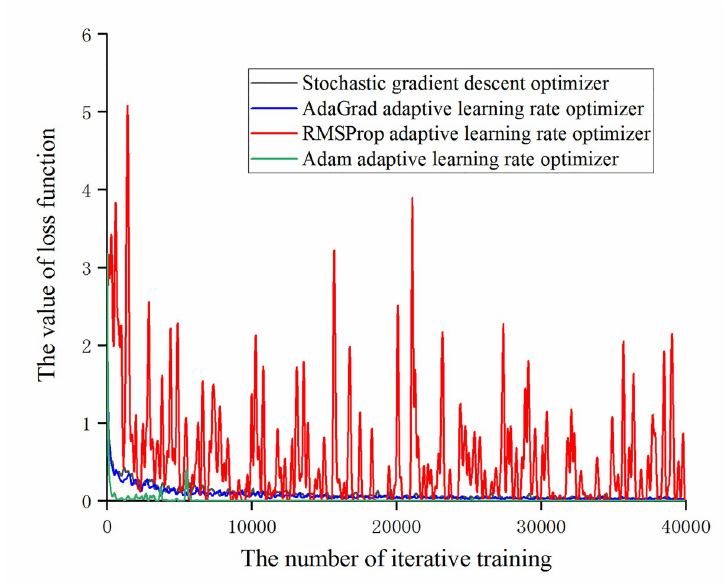
Fig 15. The trend of loss function value with the number of iterative training under different